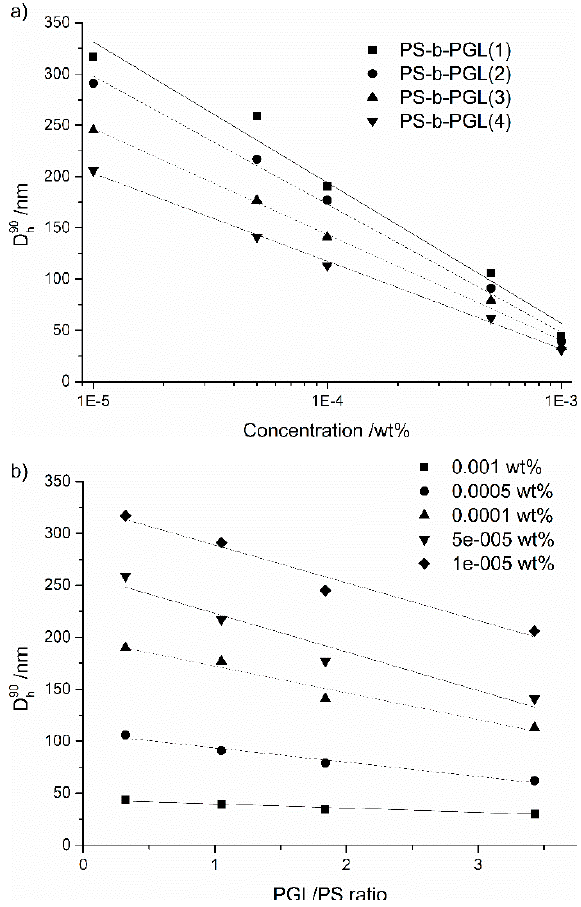
Figure 6. ( a ) Diameters of PS- b -PGL aggregates as a function of the initial copolymer concentration in dioxane, ( b ) diameters of copolymer aggregates as a function of PGL/PS ratio; aggregates formed in water/dioxane solution at 50% water content.